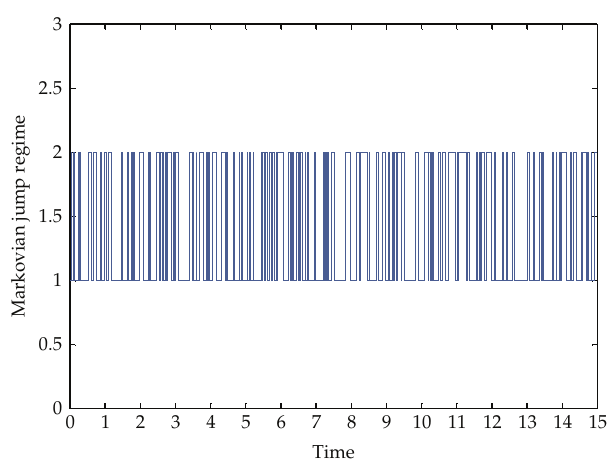
Figure 3: Simulation of Markovian